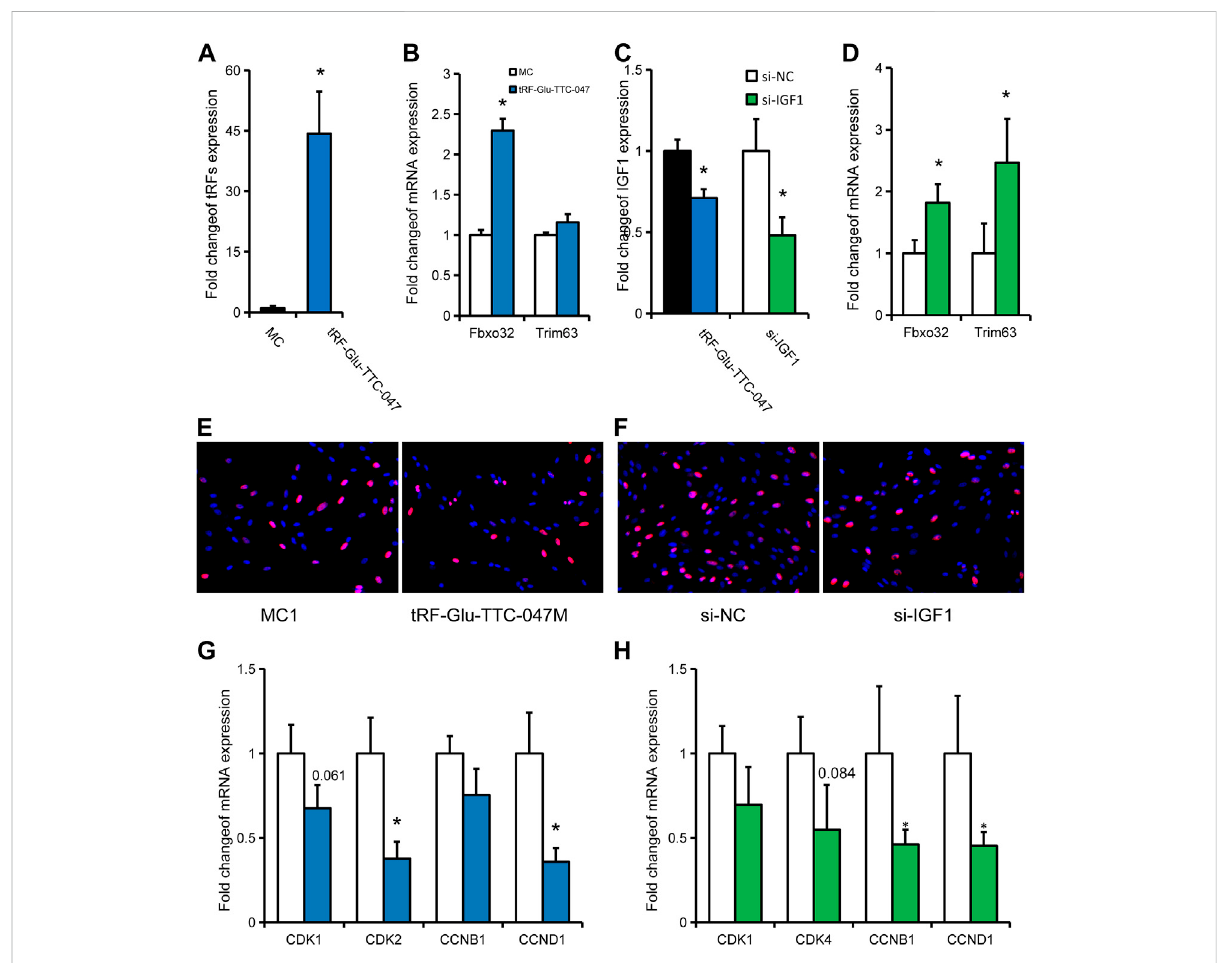
FIGURE 7 In vitro validation of tRF-Glu-TTC-047 observations. (A) Expression of tRF-Glu-TTC-047 in porcine primary cells after transfection with tRF- Glu-TTC-047 mimic. (B) Expression levels of Fbxo32 and Trim63 in porcine primary cells after transfection with tRF-Glu-TTC-047 mimic. (C) Expression levels of IGF1 in porcine primary cells after transfection with tRF-Glu-TTC-047 mimic and si-IGF1. (D) Expression levels of Fbxo32 and Trim63inporcineprimarycellsaftertransfectionwithsi-IGF1. (E,F) Eduproliferation assayaftertransfectionof(E)tRF-Glu-TTC-047mimicand (F) si-IGF1 (G) Expression of proliferation-related genes in porcine primary cells transfected with tRF-Glu-TTC-047 mimic. (H) Expression of proliferation-relatedgenesinporcineprimarycellstransfectedwithsi-IGF1.Resultsarepresentedasmean±SEMofatleastthreereplicates( n =3);* indicates statistical signi fi cance ( p <